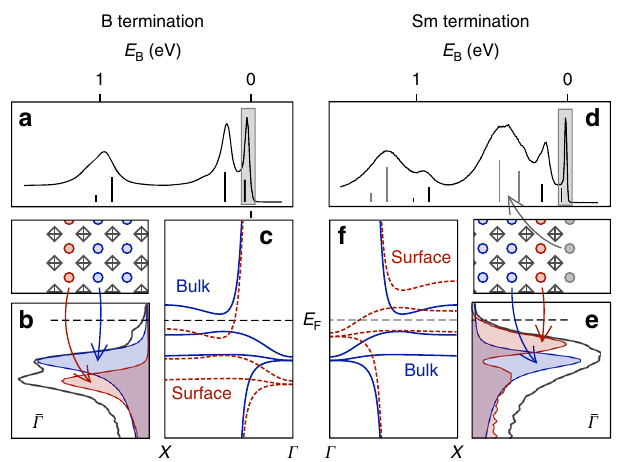
Fig. 3 Origin of the X state. a Photoelectron spectrum ( h ν = 70 eV) on a B- terminated sample. b Electron distribution curve at Γ obtained with h ν = 32 eV. A tentative assignment of the different components is given in the sketch of a bulk-truncated B-terminated surface. c Illustrates how a displacement of the hybridization region by the observed many-body resonance shift would yield a metallic surface feature around X . Solid (blue) curves show the band structure adopted from Lu et al. 3 Dashed (red) curves show the effect of a rigid displacement of the hybridization region to higher binding energy. d – f Corresponding results for the Sm-terminated